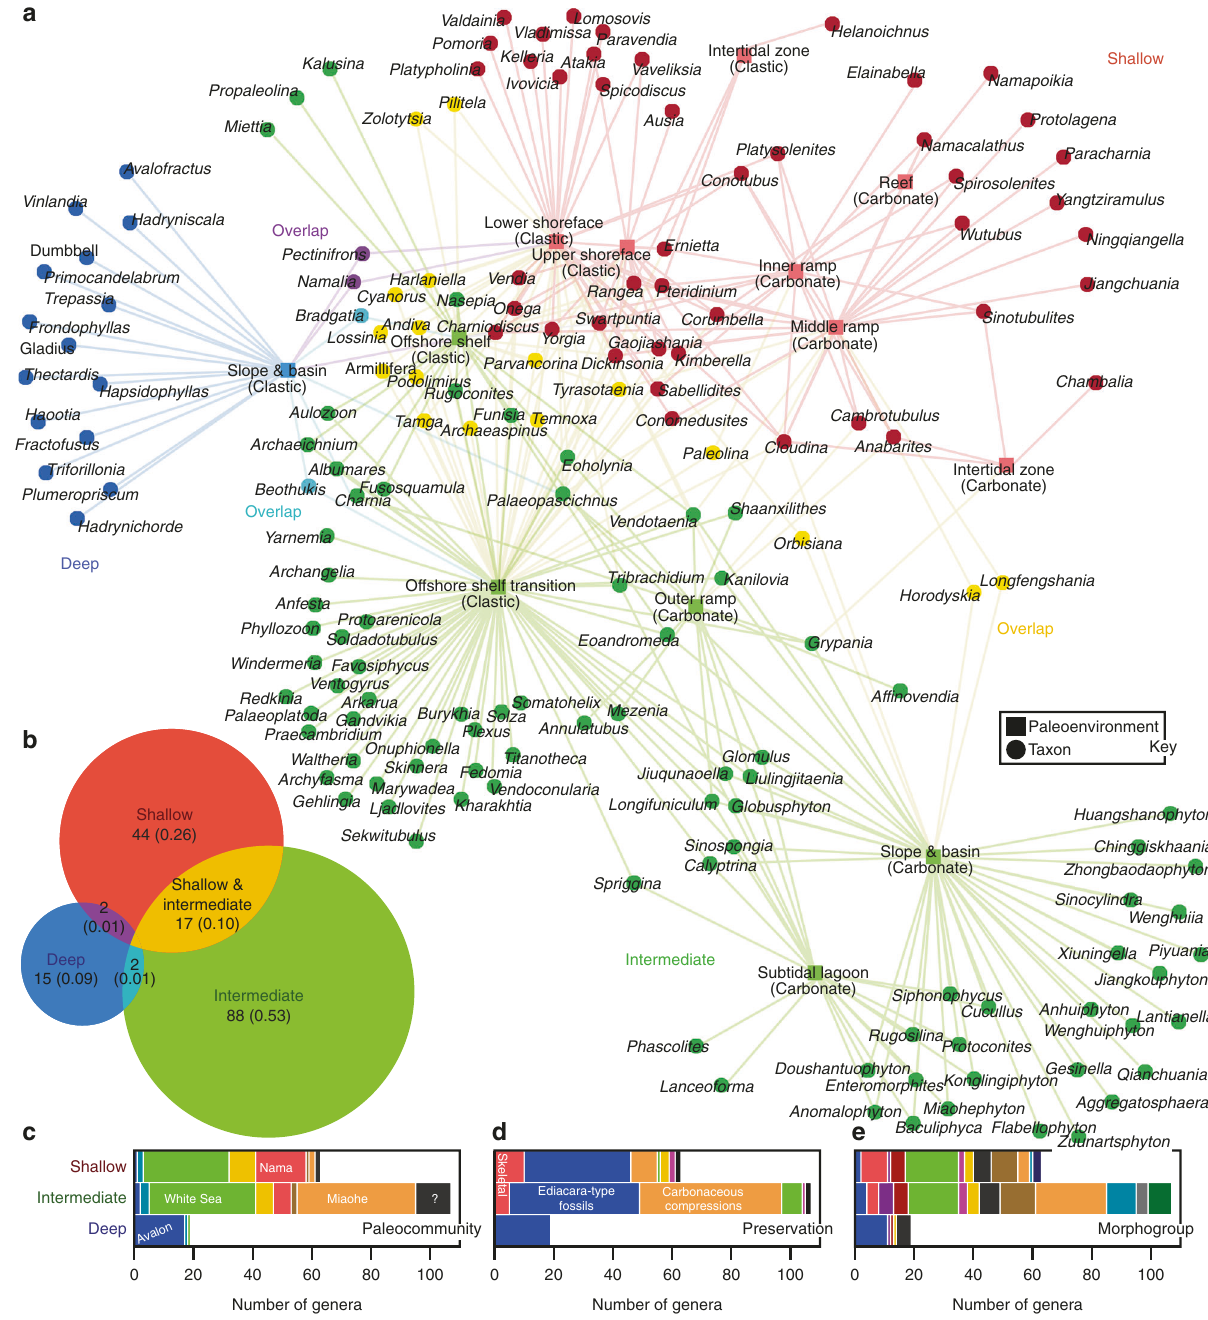
Fig. 3 Bipartite network of paleoenvironments and Ediacaran macrofossil genera. a Network graph. A genus and paleoenvironment are linked if fossils of the taxon have been reported from matching facies (Supplementary Table 4). Colors indicate modules identi fi ed using the COPRA community-detection algorithm ( v = 2). According to randomization testing, this community structure is statistically signi fi cant (Supplementary Fig. 9, paleoenvironments projection, Q = 0.39, P = 0.05, Z = 1.46; taxa projection, Q = 0.51, P = 0.05, Z = 1.27). All paleoenvironments and genera fall into three modules — the deep (blue), shallow (red), and intermediate (green) clusters — named for the relative water depths of their centroids along a model shallow-to-deep-water transect. b Venn diagram illustrating taxonomic overlap of modules. Areas of circles correspond to their relative numbers of genera, numbers are counts of taxa, and values in parentheses are proportions. c Stacked bar graph showing numbers of genera belonging to the various Ediacaran paleocommunities in each module (colors are those used in Fig. 2a, b). d, e Stacked bar graphs showing numbers of genera in the modules and their preservational modes ( d ) and morphogroups ( e ). See Fig. 2 for color keys and Supplementary Fig. 10 for related analyses. Source data are provided as a Source Data fi